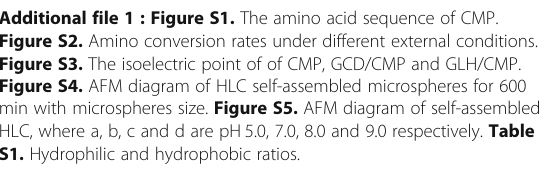
Figure S3. The isoelectric point of of CMP, GCD/CMP and GLH/CMP. Figure S4. AFM diagram of HLC self-assembled microspheres for 600 min with microspheres size. Figure S5. AFM diagram of self-assembled HLC, where a, b, c and d are pH 5.0, 7.0, 8.0 and 9.0 respectively. Table S1. Hydrophilic and hydrophobic